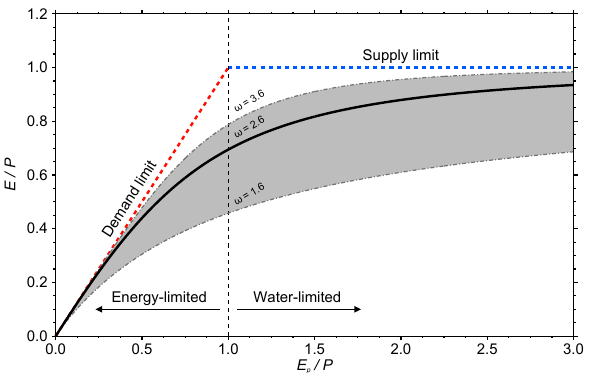
Figure 1. The traditional Budyko curve (solid black curve), cor- responding to ω = 2 . 6 in Eq. (3). The ω = 2 . 6 ± 1 curves are also shown (dot-dashed grey curves bounding the shaded region). The atmospheric supply limit ( E < P ; horizontal dashed blue line) and atmospheric demand limit ( E < E p ; diagonal dashed red line) are shown. Energy-limited conditions are represented to the left of the vertical dashed black line ( E p P < 1), and water-limited conditions are represented to the right ( E p /P >